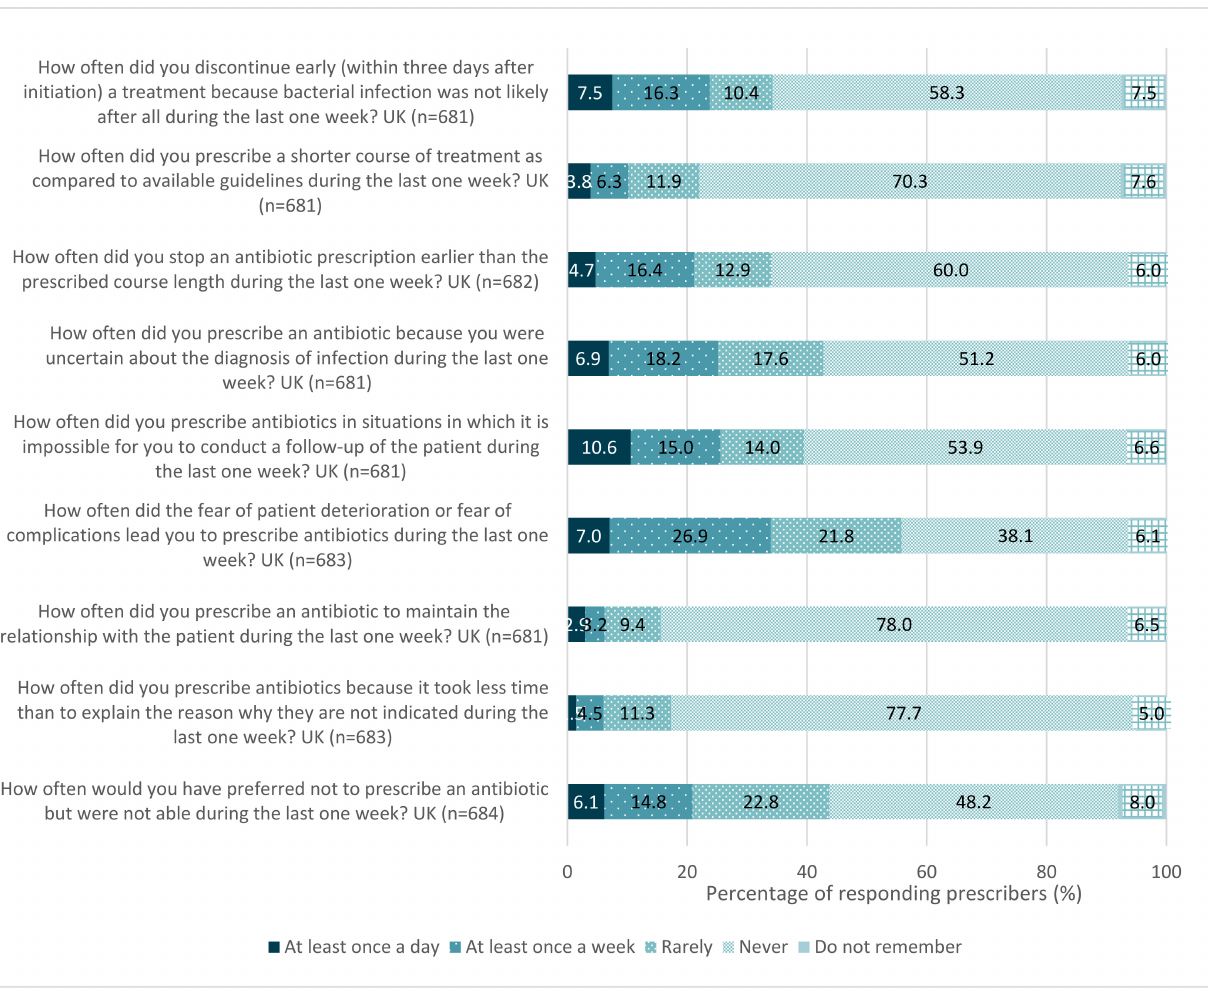
Figure 5. Reasons prescribers initiated antibiotic prescriptions when they would have preferred not to in the previous week, UK, 2019. Table 2. Responses from UK prescribers to the motivation